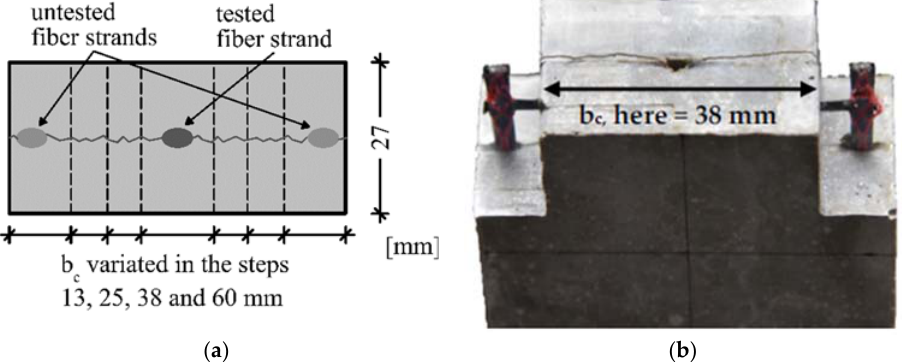
Figure 6. ( a ) Variation of the concrete width (b c ); ( b ) implementation in the specimen (here b c = 38